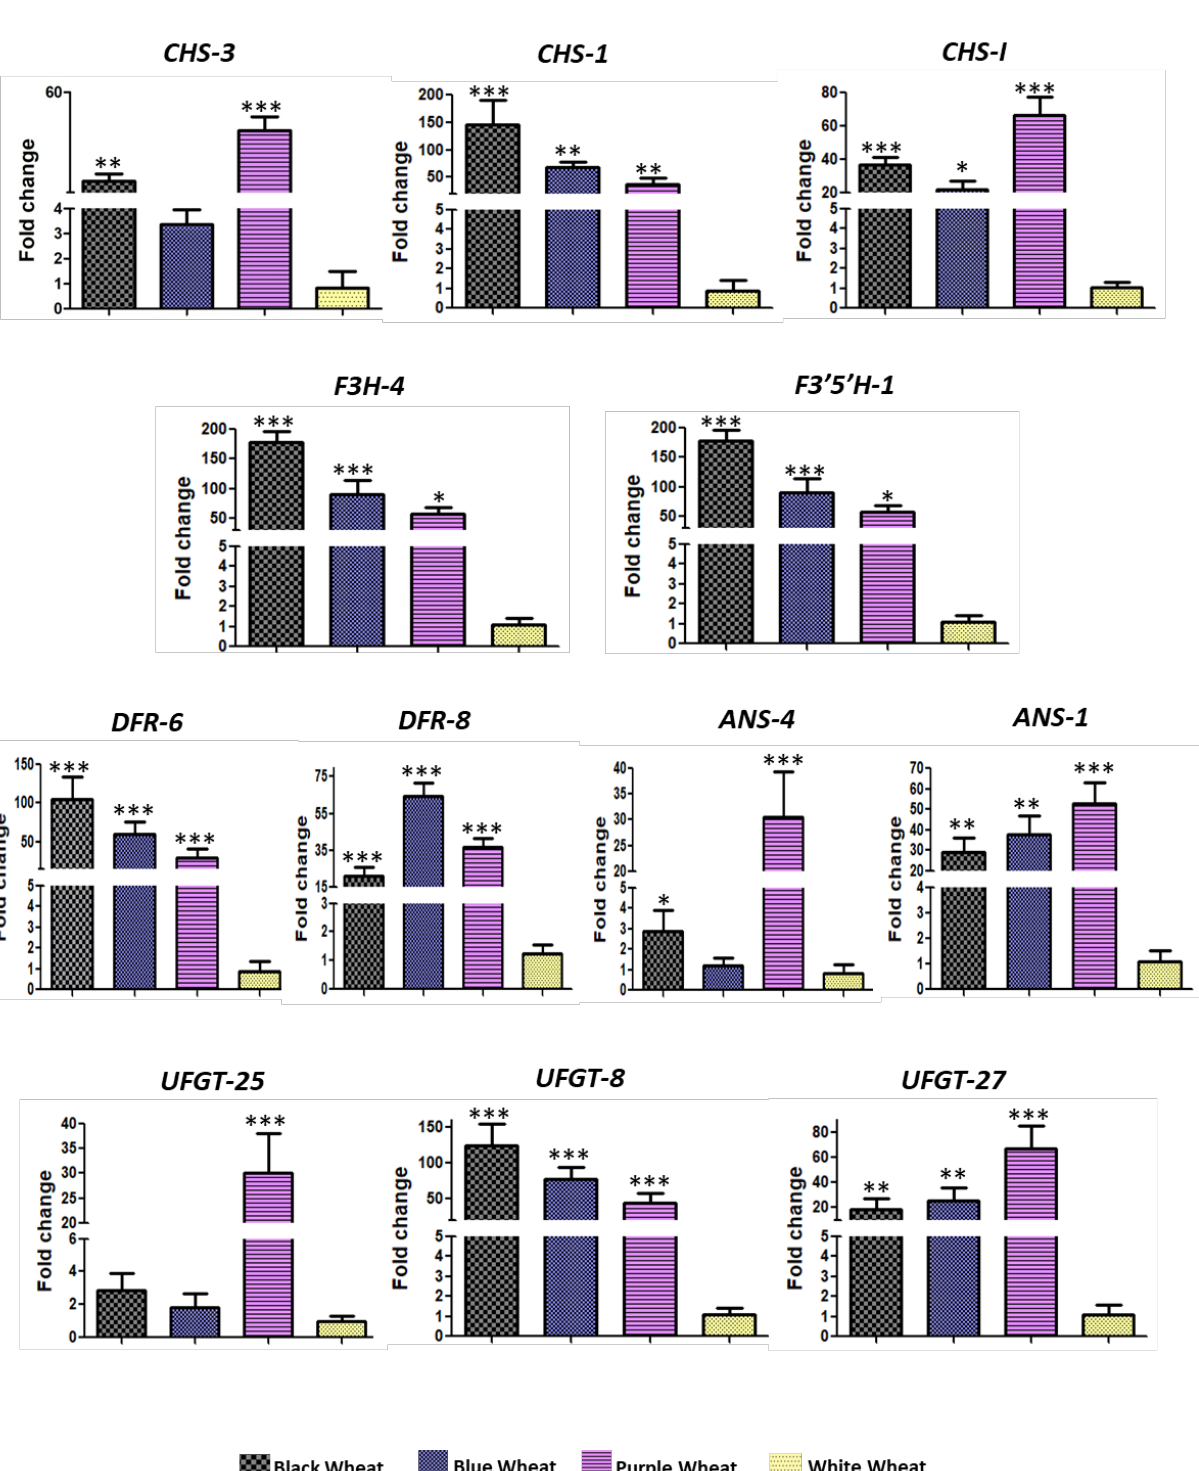
Figure 3. Quantitative real time PCR-based expression validation of selected genes. Significance level was represented by * depicting the p -value < 0.05, ** depicting the p -value < 0.001 and *** depicting the p -value < 0.0001 in comparison to white wheat.